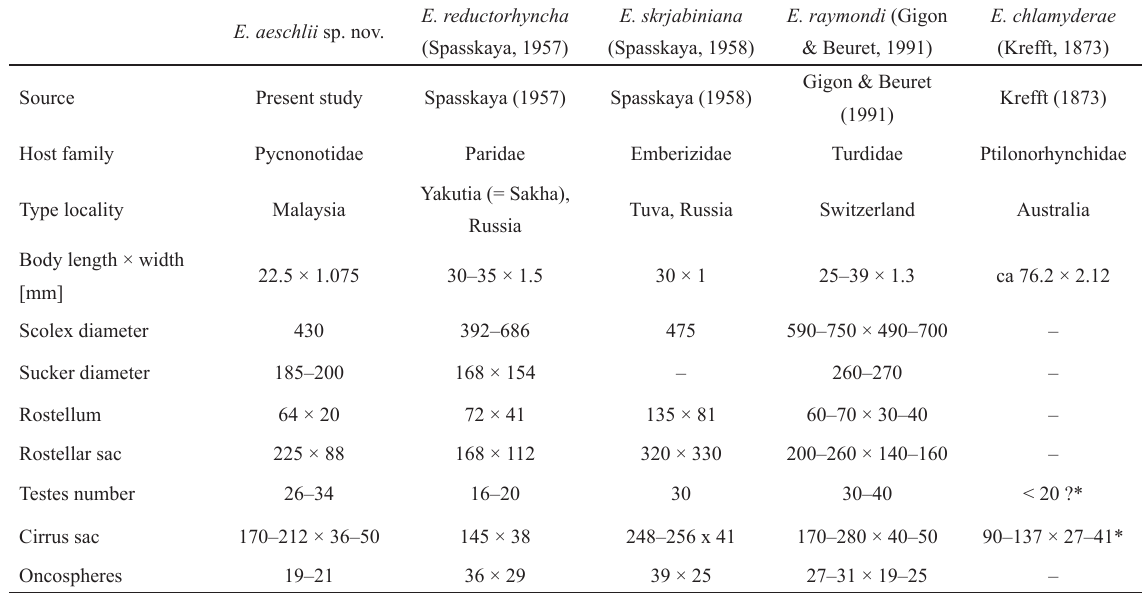
Table 1. Main morphological characteristics of species of Emberizotaenia Spasskaya, 1970. * With additional counts or measurements from sections of type